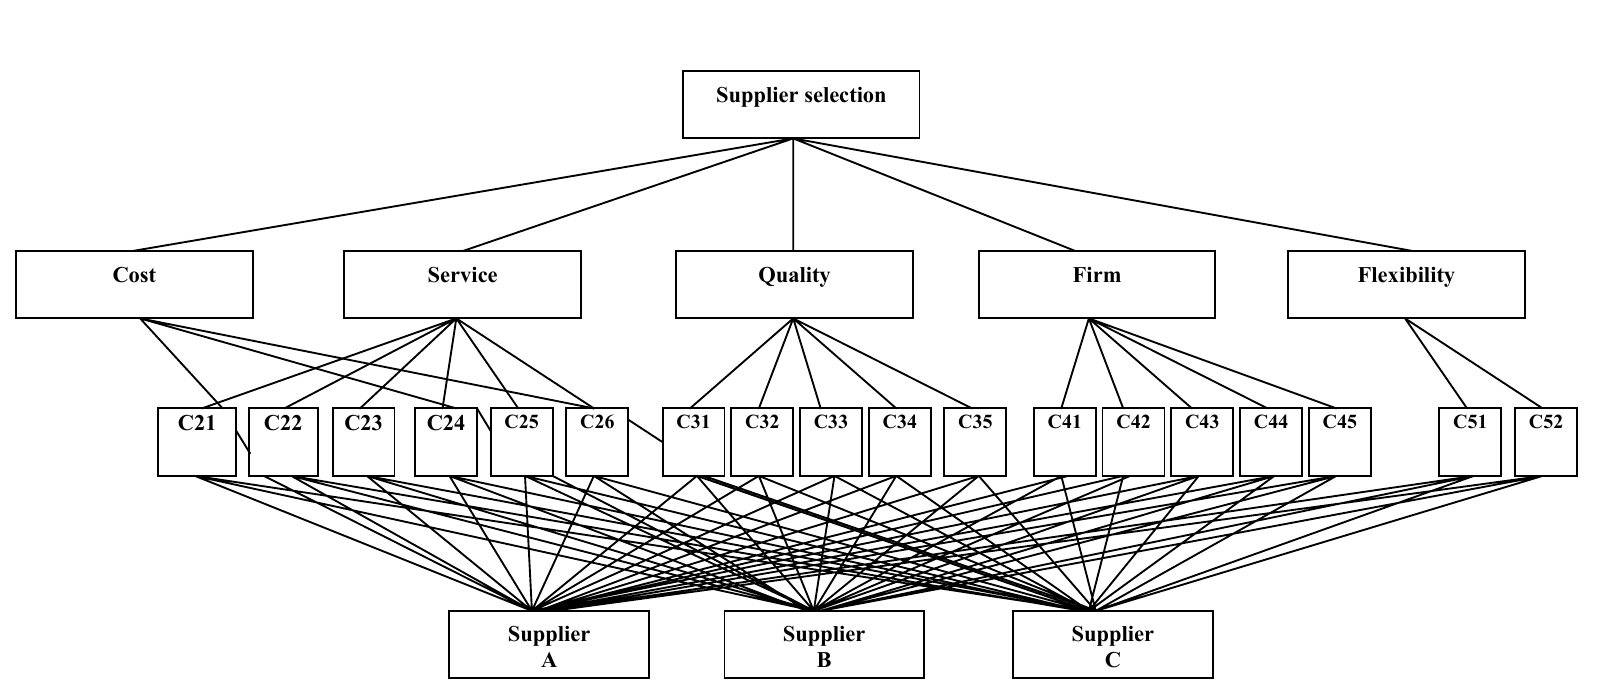
Fig. 4. The hierarchy for selection among the